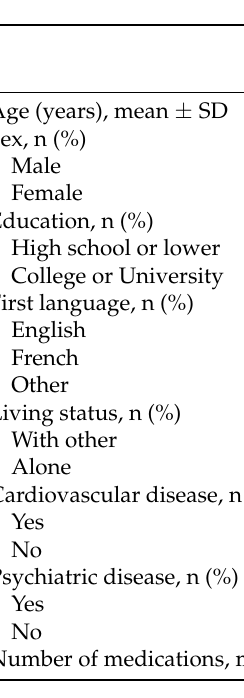
Table 1. Baseline characteristics by referral